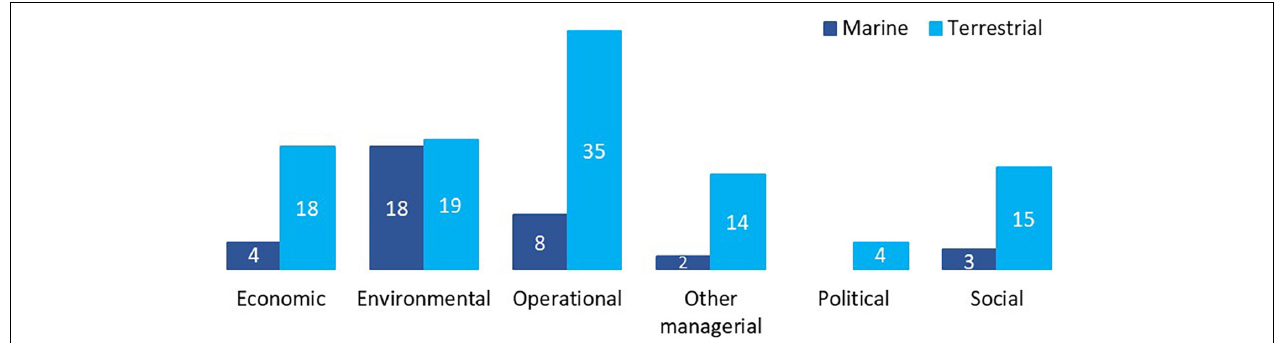
FIGURE 5 | Number of criteria by marine and terrestrial